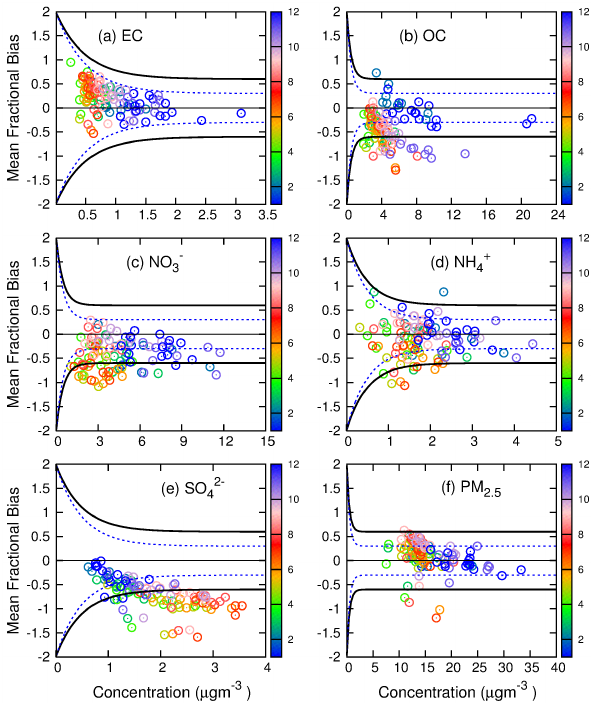
Figure 2. Monthly mean fractional bias (MFB) of PM 2 . 5 EC, OC, nitrate, ammonium, sulfate, and total mass. Solid lines represent the MFB criteria, and the blue dash lines represent the MFB goals.